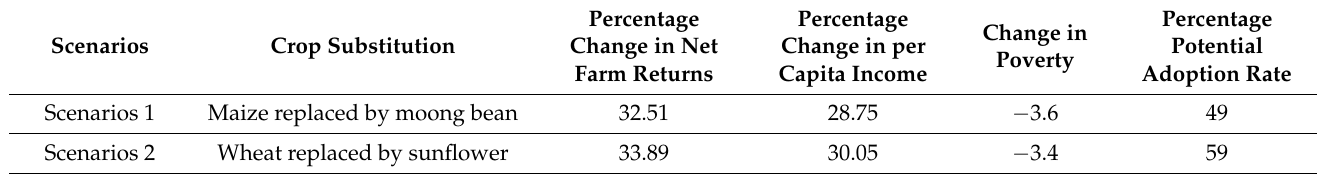
Table 3. Economic benefits of the adoption of low-delta